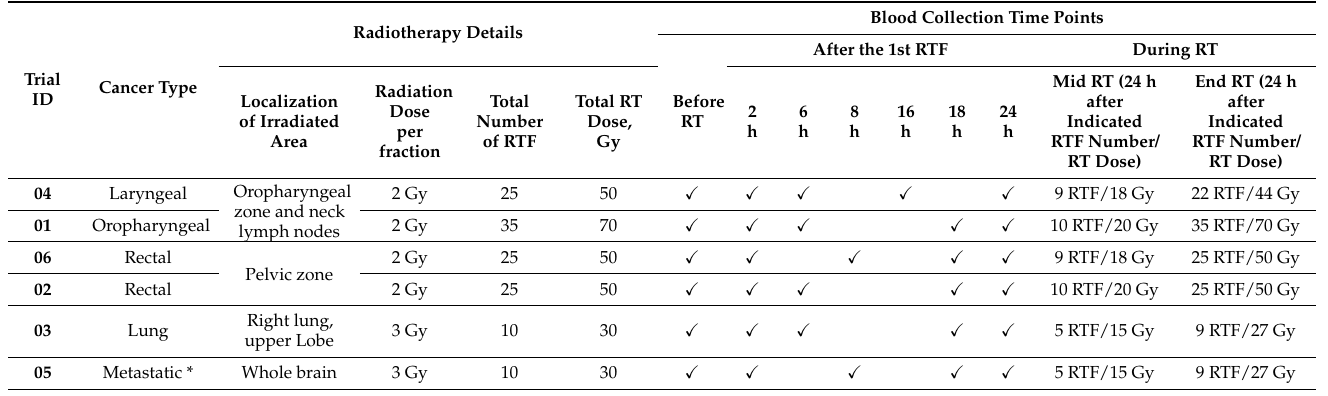
Table 1. Description of the patients’ radiotherapy treatments and blood collection time